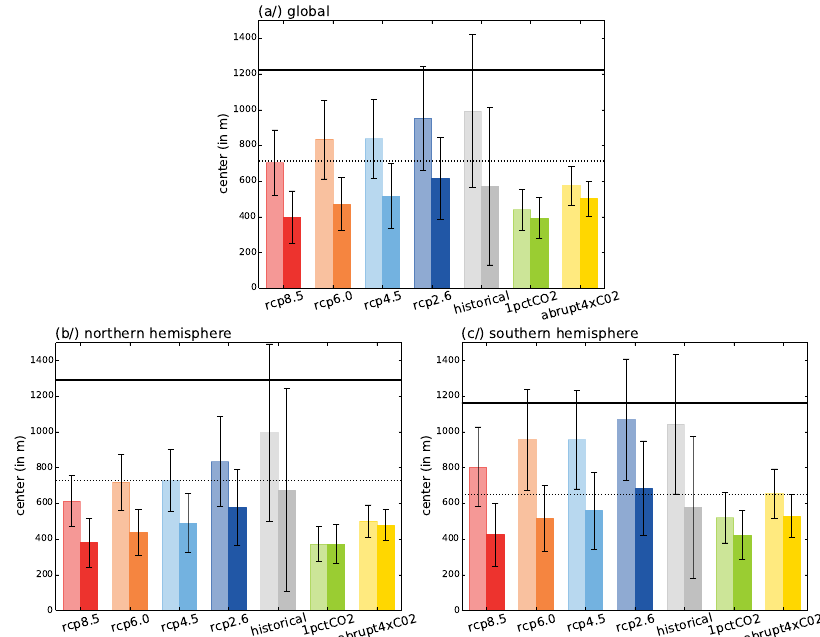
Figure 5. CMIP5 multi-model mean depth and standard deviation (in m) where the individual model mean (left bar) and median (right bar) depth of thSLR originates for the four RCP scenarios, as well as the historical scenario and the two idealized CO 2 -forcing scenarios. Thermal expansion estimates are derived from Eq. (2) based on (a) globally, (b) northern and (c) southern hemispherically averaged vertical potential temperature profiles, followed by a temporal averaging over the last 20years (see Figs. 3 and 4). Table S5 summarizes the estimates. The horizontal solid (dashed) line indicates the mean (median) depth of thSLR based on climatological temperature and salinity profiles (Boyer et al.,